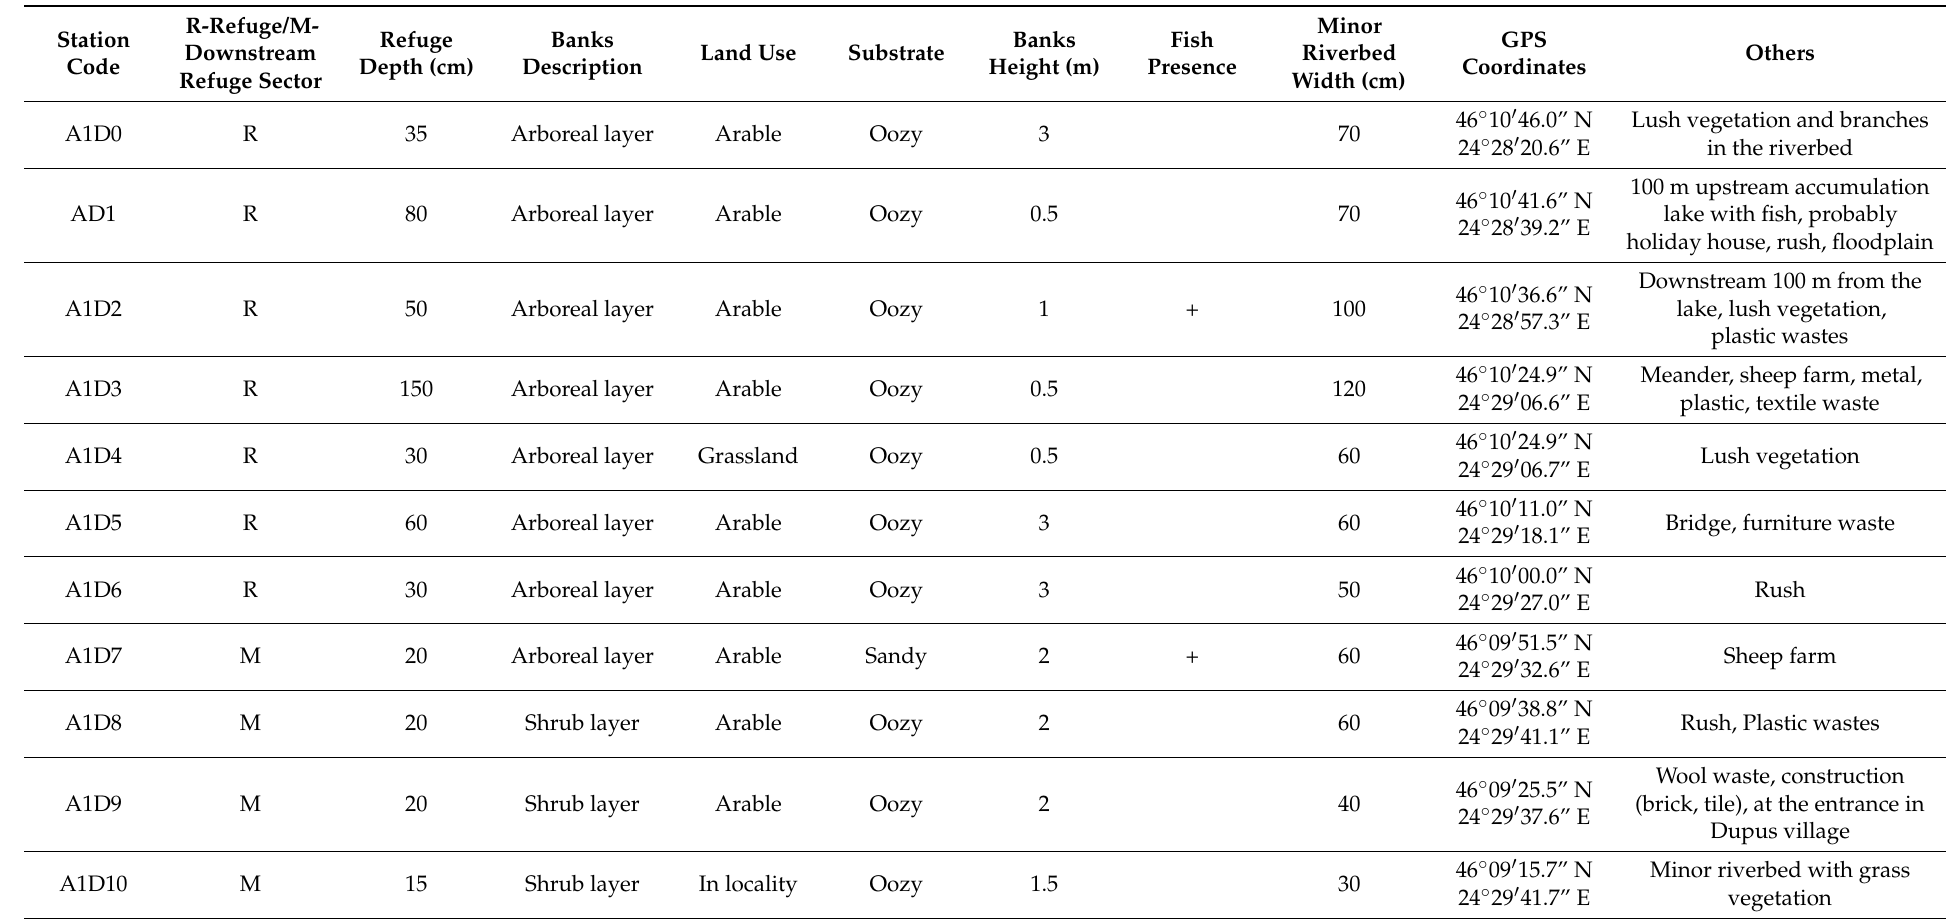
Table A1. Dupu¸s River Habitat